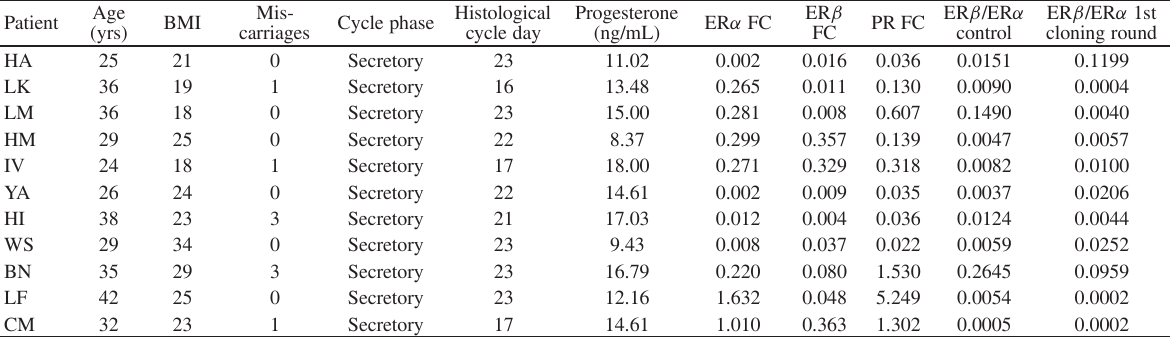
TABLE 1: Clinical characteristics of patients and change of hormone receptor expression after the first cloning round.